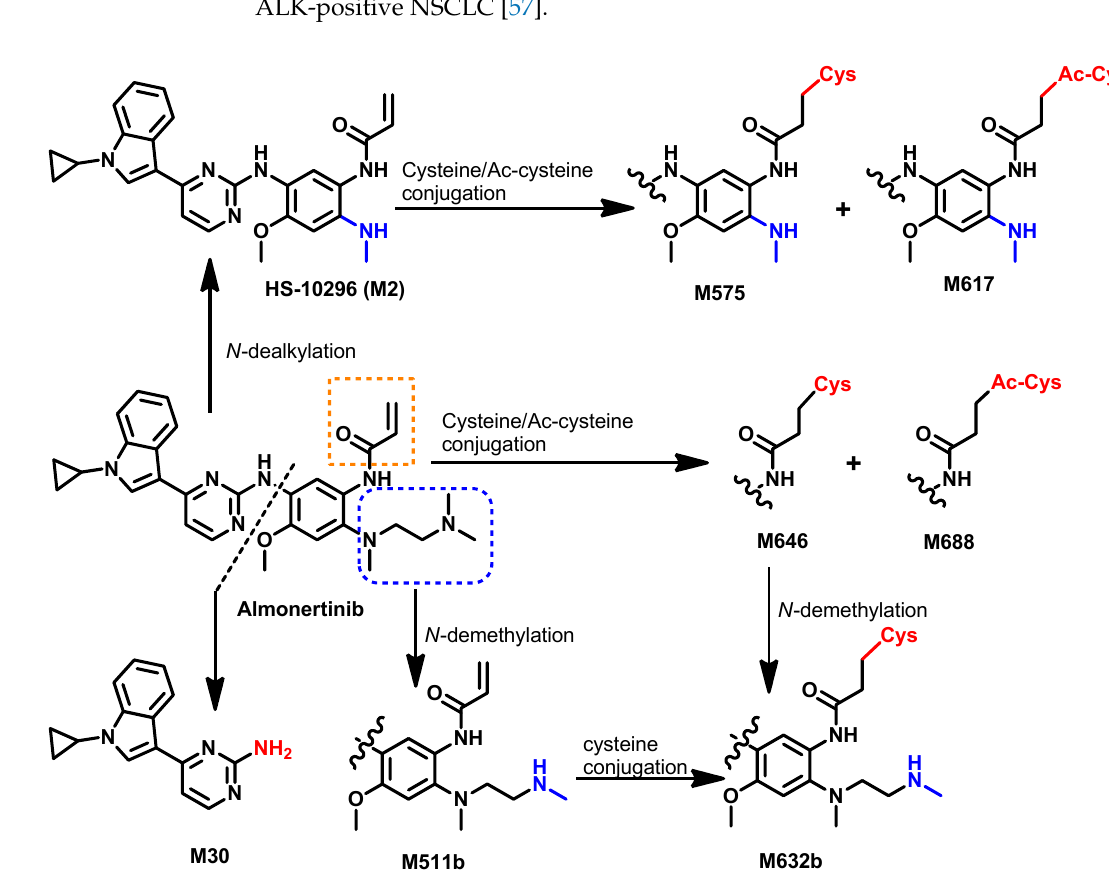
Figure 15. Proposed metabolic pathways of almonertinib.